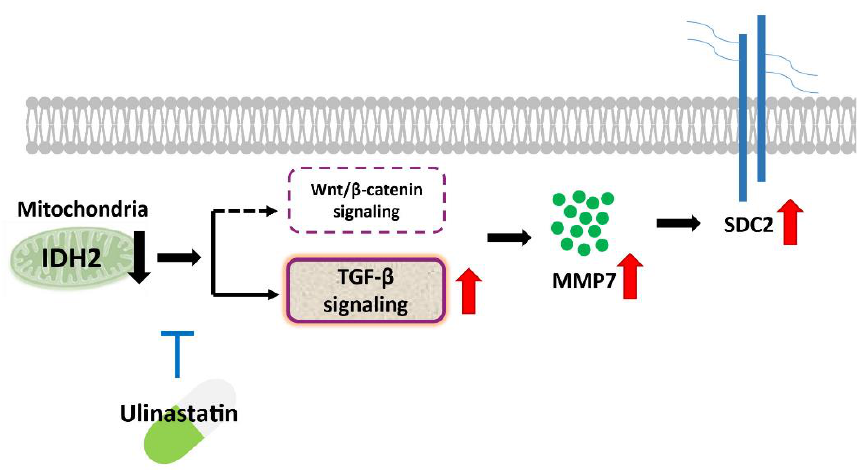
Figure 5. Schematic representation of the proposed pathway of SDC2 activation in IDH2 deficiency condition.